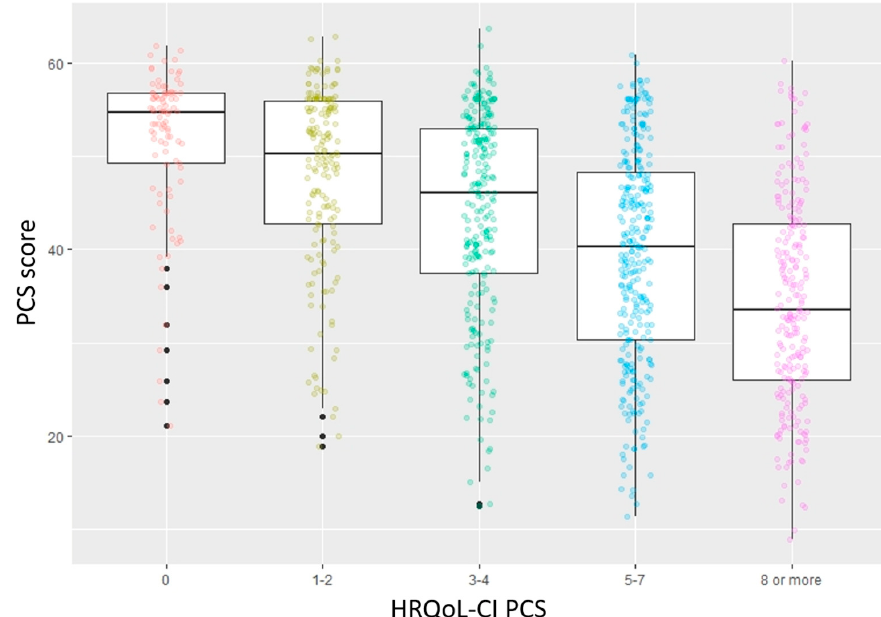
Figure 3. Results for concurrent criterion validity of Physical Component Summary Score in the Short-Form 12-Item Survey—version 2 among an older (65 years or greater) US population (PCS score: Physical Component Summary Score; HRQoL-CI PCS: Health-Related Quality of Life Comorbidity Index (Physical Component